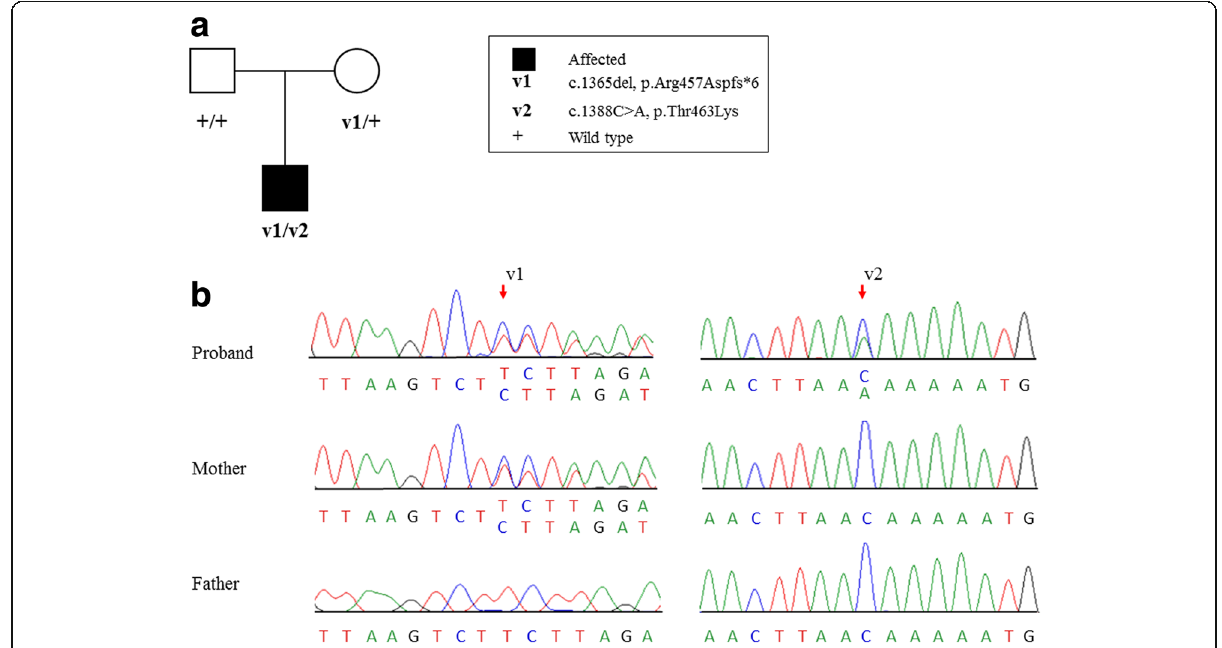
Fig. 2 CHUK pathogenic variants and segregation studies. a Family pedigree showing segregation studies; b Sanger sequencing indicates that the c.1365del variant was maternally-inherited. The c.1388C> A (p.Thr463Lys) was not detected in either parental sample. Paternity was